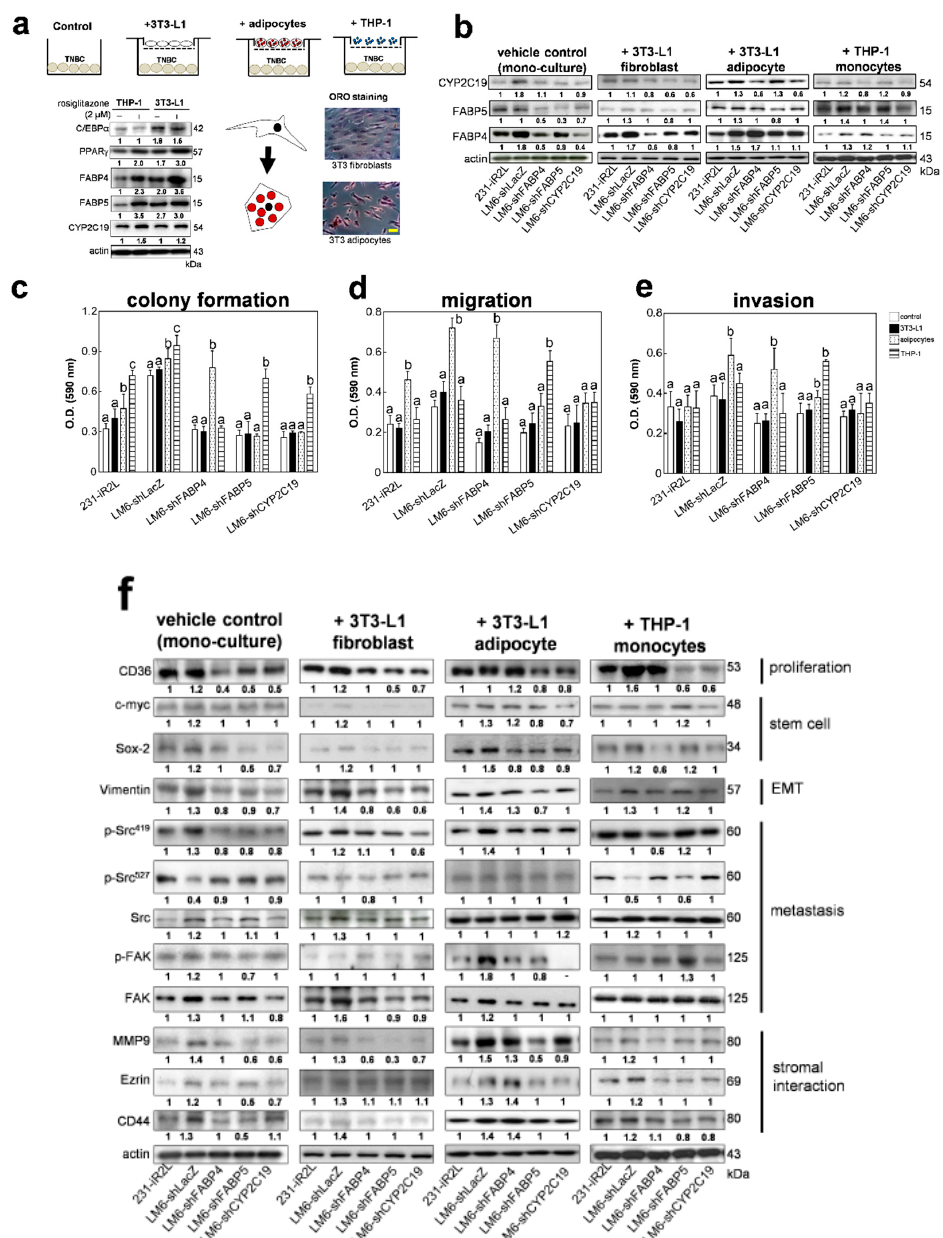
Figure 4. Expression of FABP4 and FABP5 are induced by co-culture of metastatic TNBC cells with stromal cells. ( a ) Schematic diagram showing co-culture of TNBC cells (1 × 10 6 ) with 3T3-L1 murine fibroblasts, 3T3-L1 differentiated adipocytes, and monocytes THP-1. (Left) Western blot analysis of adipocyte markers and intrinsic expression levels of FABP4, FABP5, and CYP2C19 in fibroblasts, adipocytes, and monocytes grown in monoculture, with or without the addition of 2 µM rosiglitazone (adipocyte differentiation factor and PPAR- γ agonist). (Right) Oil Red O staining differentiates 3T3 and mature adipocytes, following differentiation at 10 days; scale bar for images set at 10 µm ( b ) expression levels of FABP4, FABP5, and CYP2C19 in 231-iR2L, LM6, and FABP4/FABP5CYP2C19-depleted cells co-cultured with stromal cells. The effects of co-culture on the ( c ) colony formation, ( d ) migration, and ( e ) invasion capacities of the TNBC cells; and ( f ) expression levels of FABP-EET network markers in MDA-MB-231, LM6, and FABP4/FABP5CYP2C19-depleted cells co-cultured with stromal cells. All analyses include 3 biological replicates and 4 technical replicates. Error bars indicate mean ± SEM. Statistical significance of the data between di ff erent groups are denoted by di ff erent letters ( p = 0.05, ANOVA, post hoc